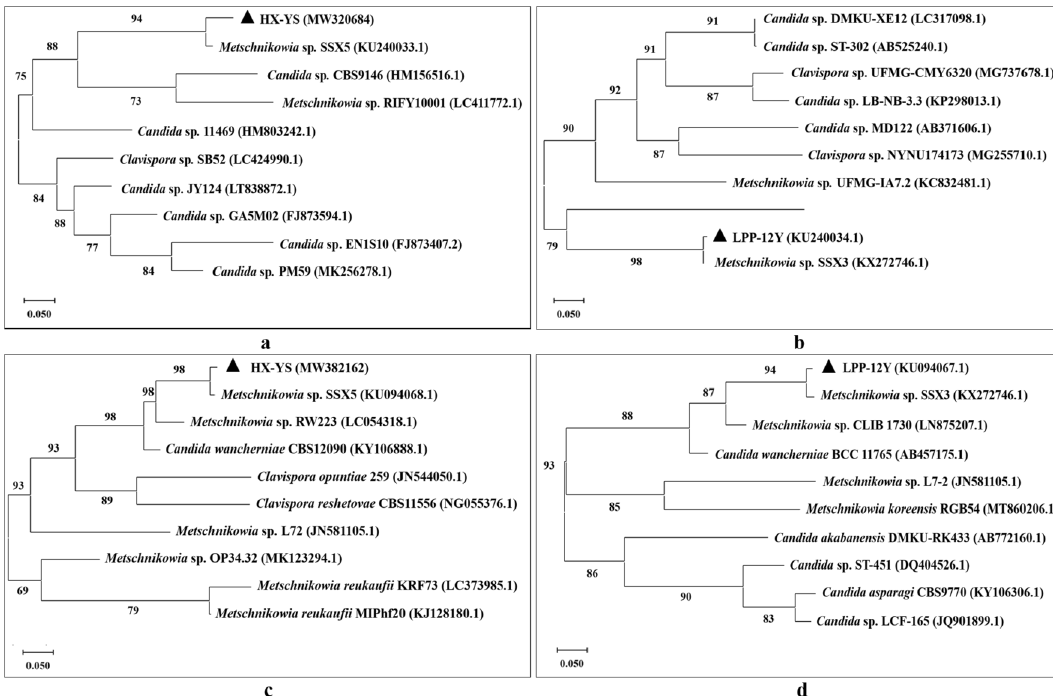
Figure 3. Phylogenetic tree based on the ribosomal DNA-ITS fragments [( a ) HX-YS; ( b ) LPP-12Y] and 26S rDNA D1/D2 regions [( c ) HX-YS; ( d ) LPP-12Y] of two novel yeasts strains constructed using the neighbor- joining method.